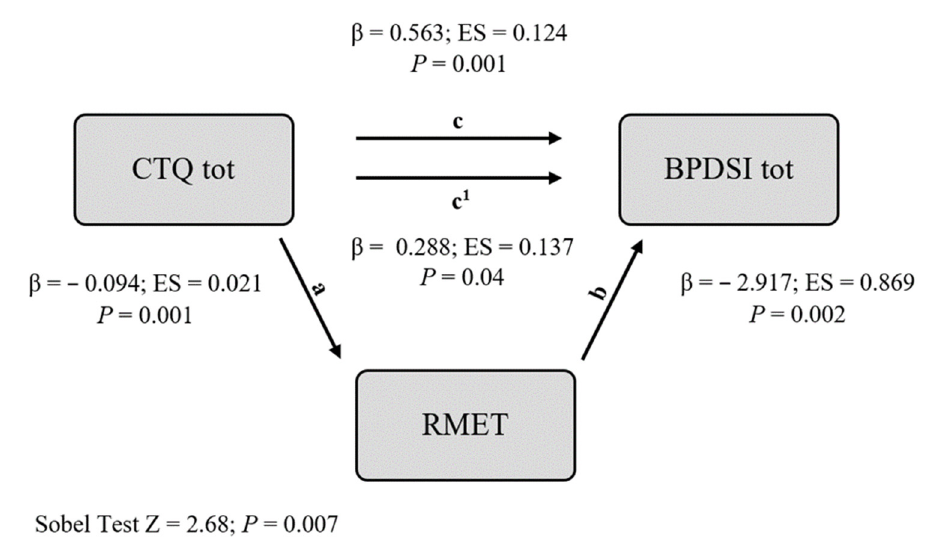
Figure 2. Mediational model (M = RMET). Table 3. Mediational model (M = BCSTc).